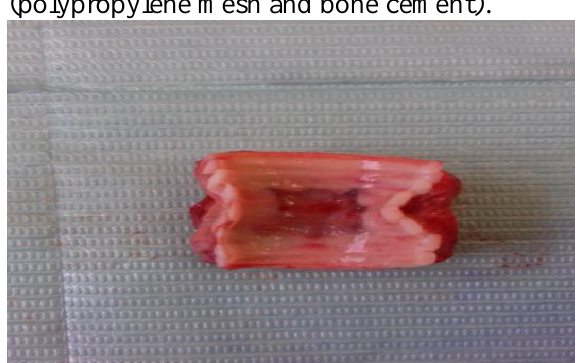
Figure, 9: Shows tracheal defect of dog was still appeared at 30 postoperative day in G1.